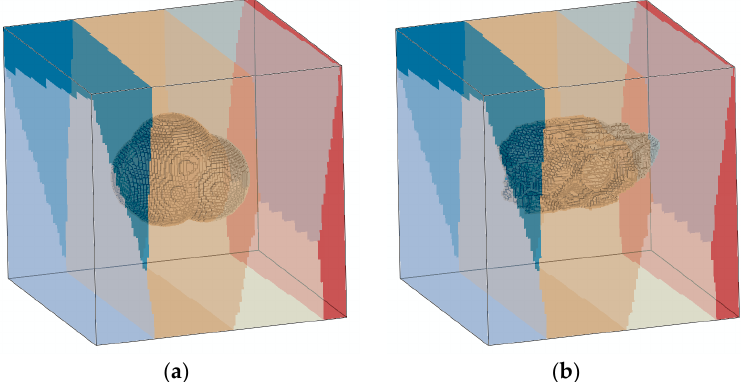
Figure 8. Exemplary virtual microstructure models of grains with embedded pore: ( a ) Round pore with convex boundary; ( b ) Elongated pore with concave boundary. Different colors indicate individual grains.